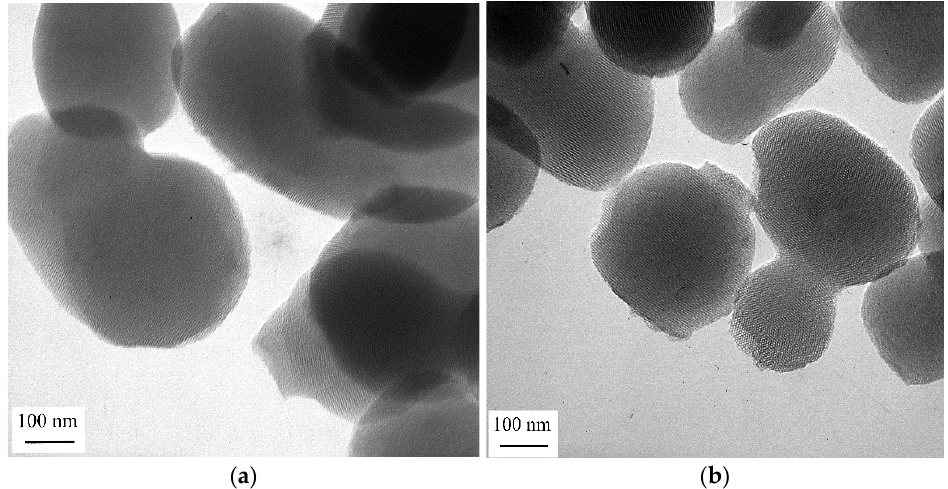
Figure 5. Characteristic TEM images of mesoporous silica prepared at room temperature without 2-methoxyethanol ( a ) and in solvent with 3:1 methoxyethanol/ethanol ratio ( b ).